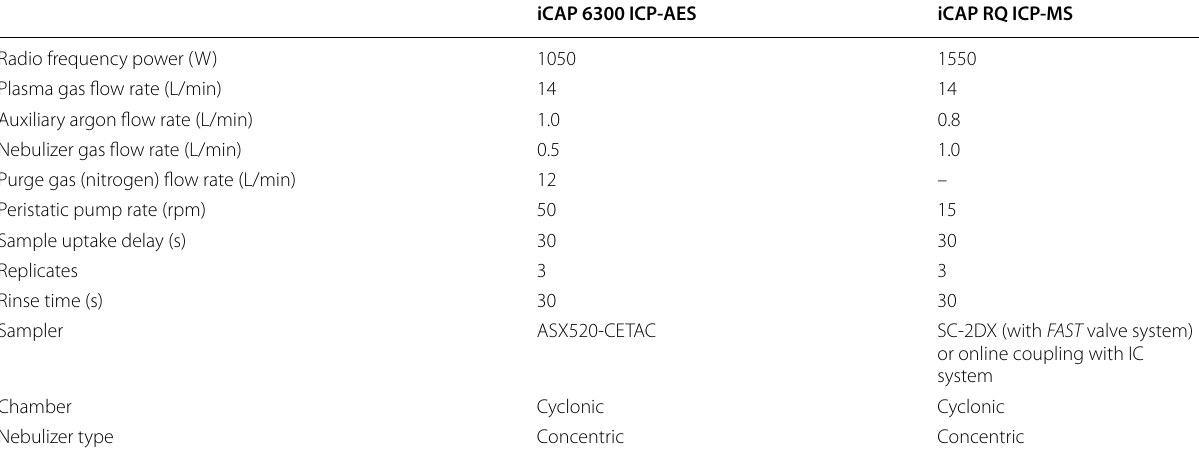
Table 2 Optimized operating conditions for ICP‑AES and